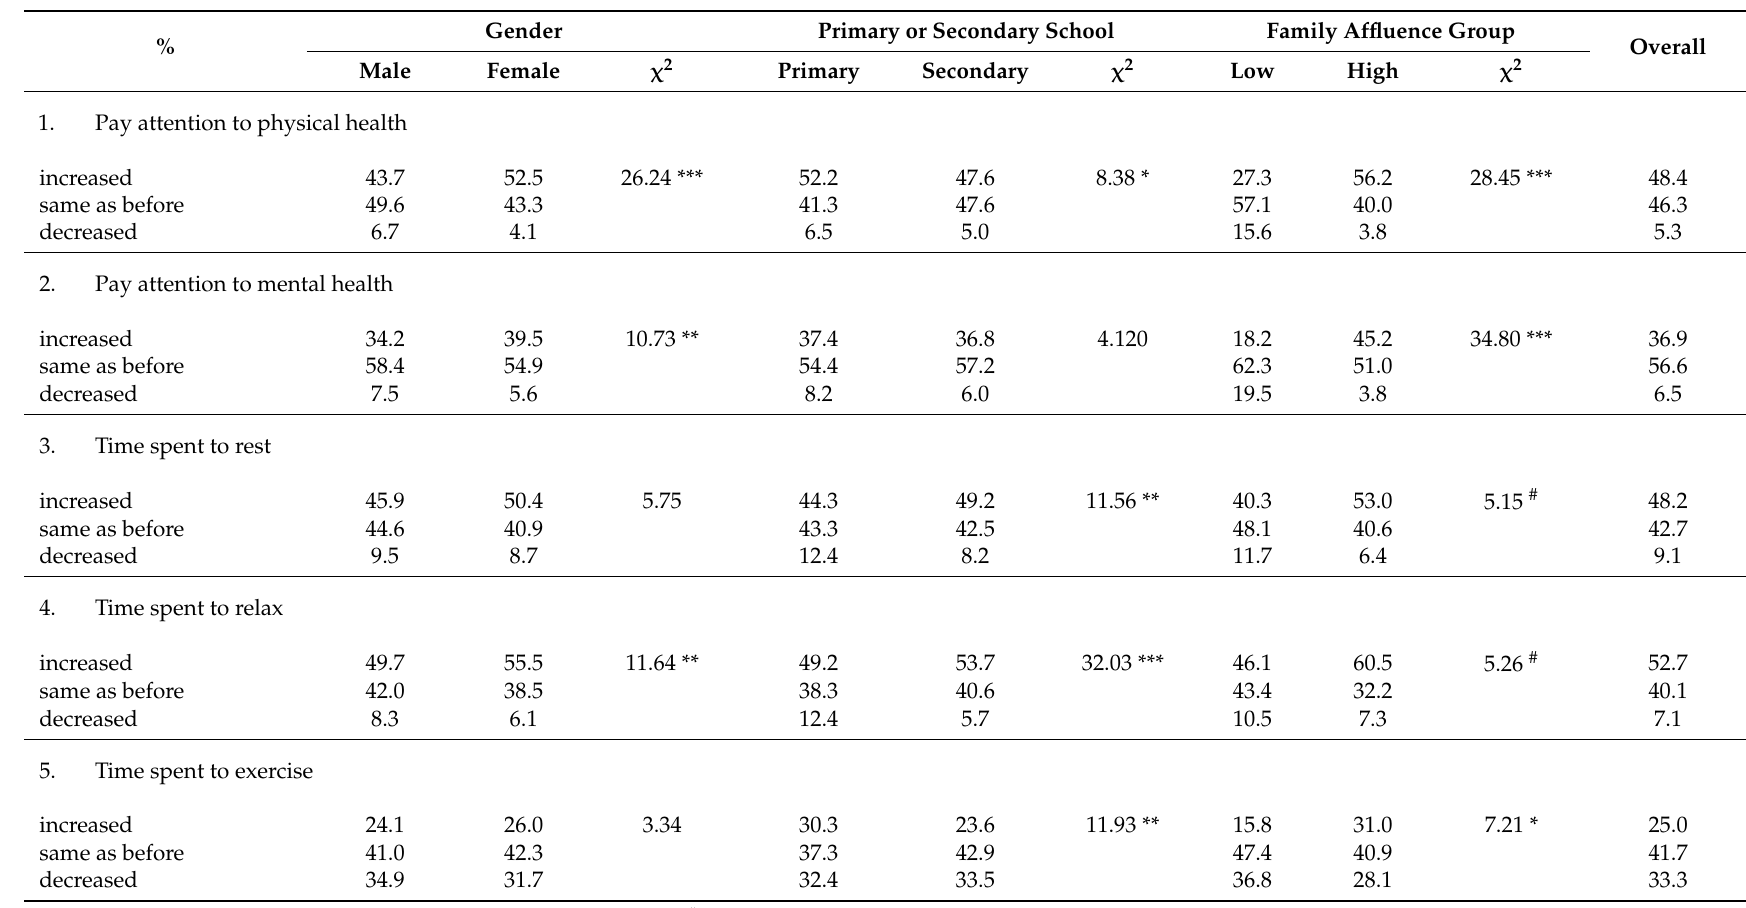
Table 2. The positive impact on lifestyle changes by groups with Chi-Square ( χ 2 ) Test ( N =